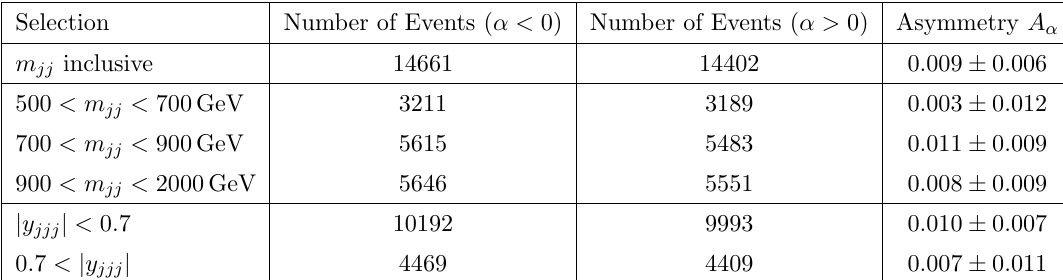
Table 3 . Measured asymmetry of (cid:11) for the inclusive selection as well as three invariant mass regions of the leading and sub-leading jet as well as two rapidity regions of the three jet system y jjj . The uncertainties are statistical only.